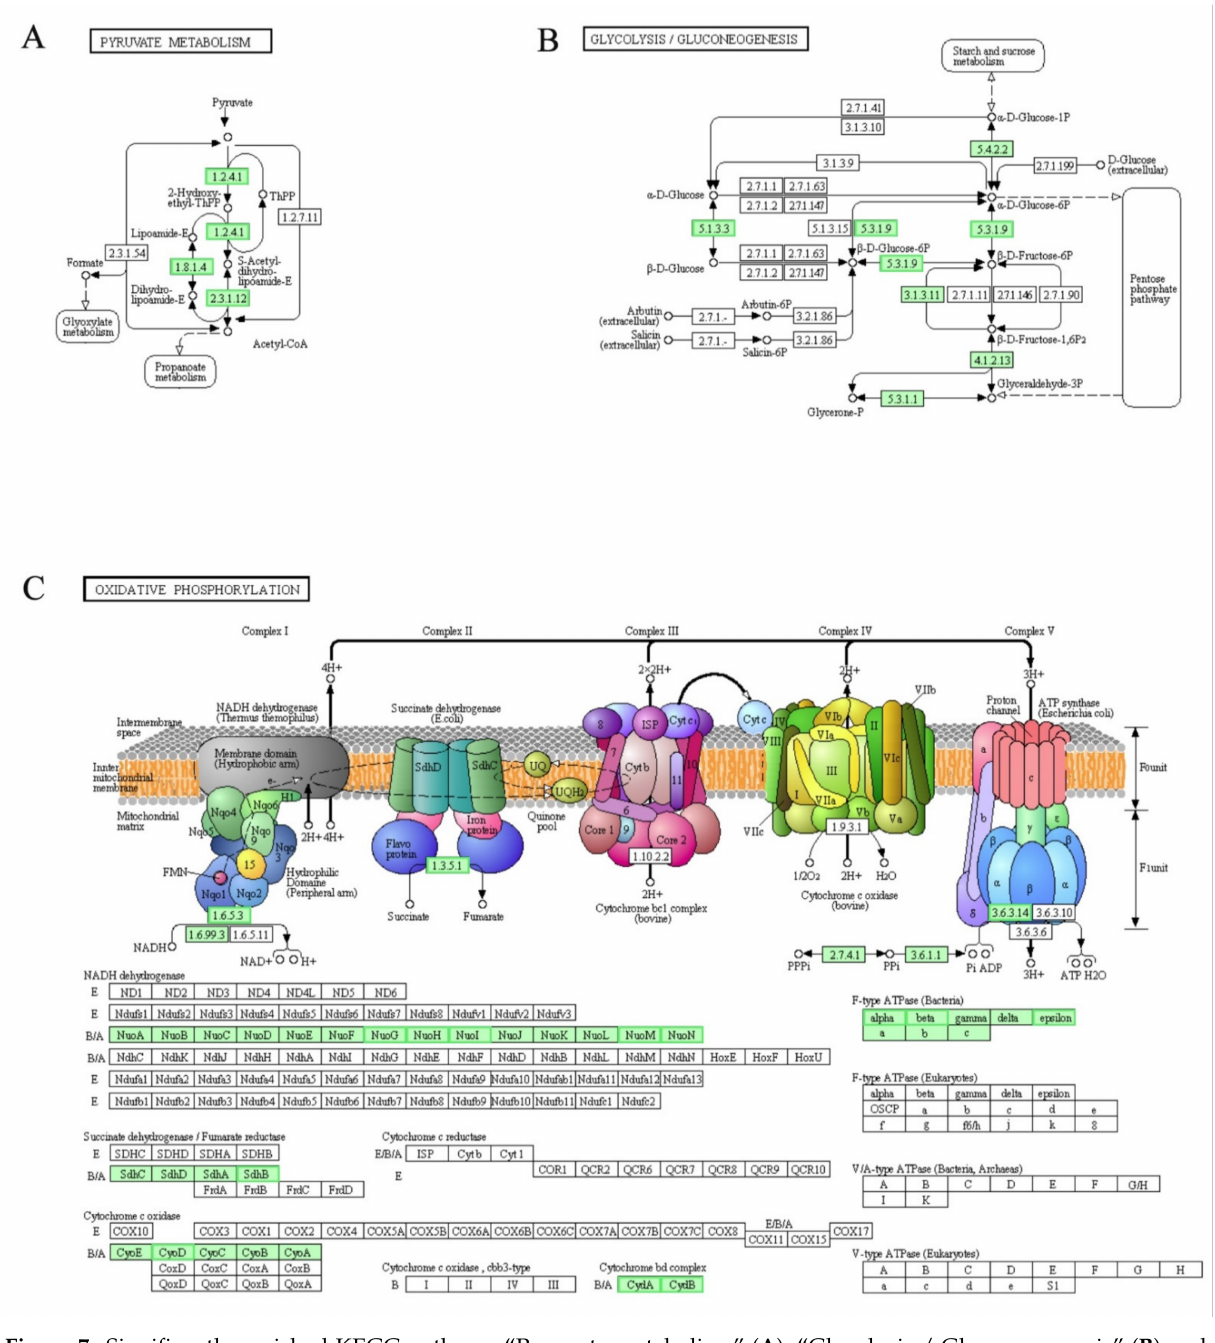
Figure 7. Significantly enriched KEGG pathway “Pyruvate metabolism” ( A ), “Glycolysis / Gluconeogenesis” ( B ) and “Oxidative phosphorylation” ( C ); (from KEGG database, green rectangles represent proved Organism-specific gene product and green frames represent down-regulation and red frames represent